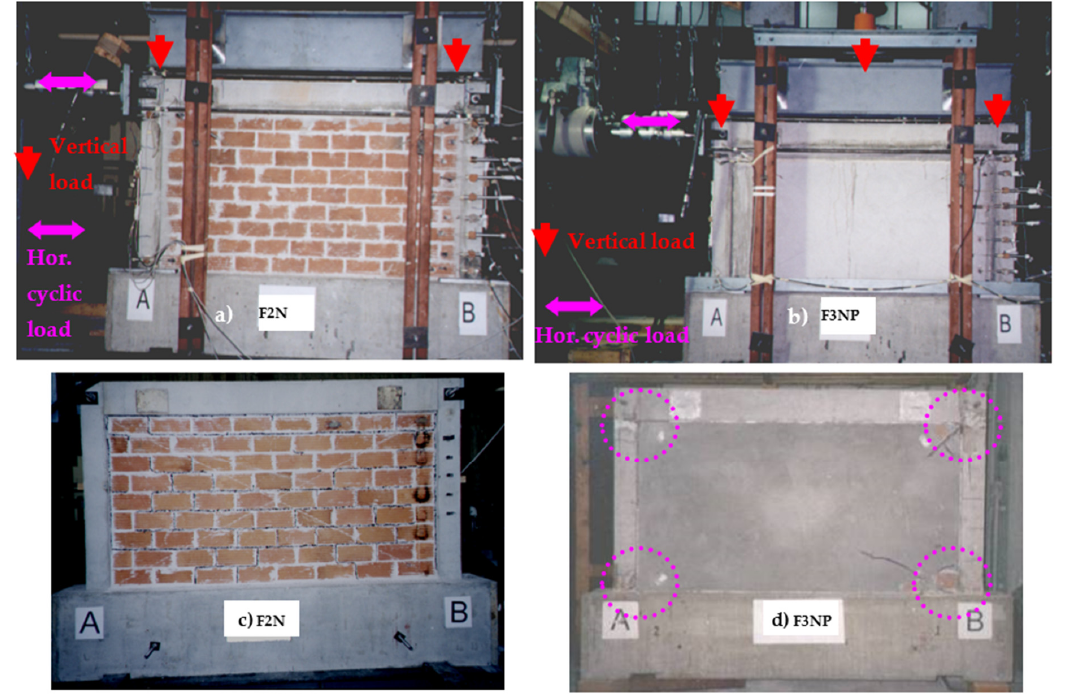
Figure 8. ( a ) The loading arrangement for F2N ‐ UMI specimen (second row of Table 2) ( b ) The loading arrangement for F3NP ‐ UMI specimen after having applied the cement mortar with the wire net (last row of Table 2). ( c ) Observed damage for F2N ‐ UMI specimen ( d ) Observed damage fir F3NP specimen [23,44].